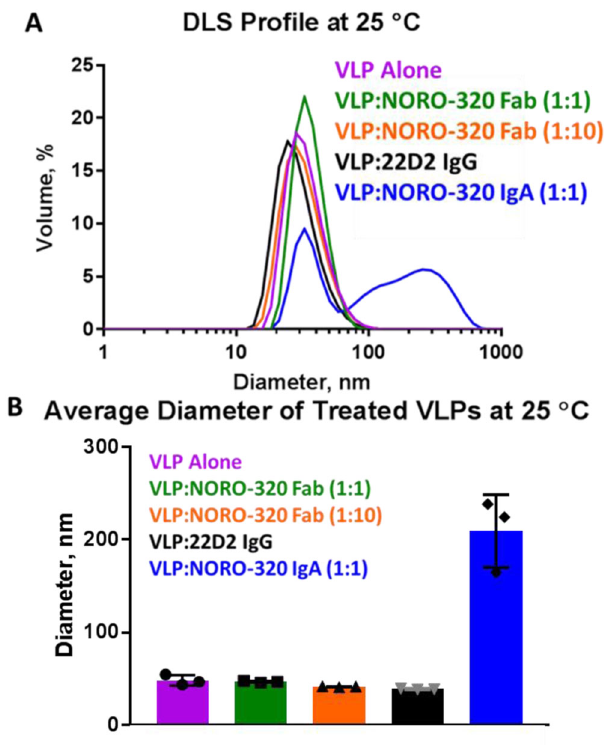
Fig. 9 Dynamic light scattering of mAb NORO-320 and GII.4 Sydney